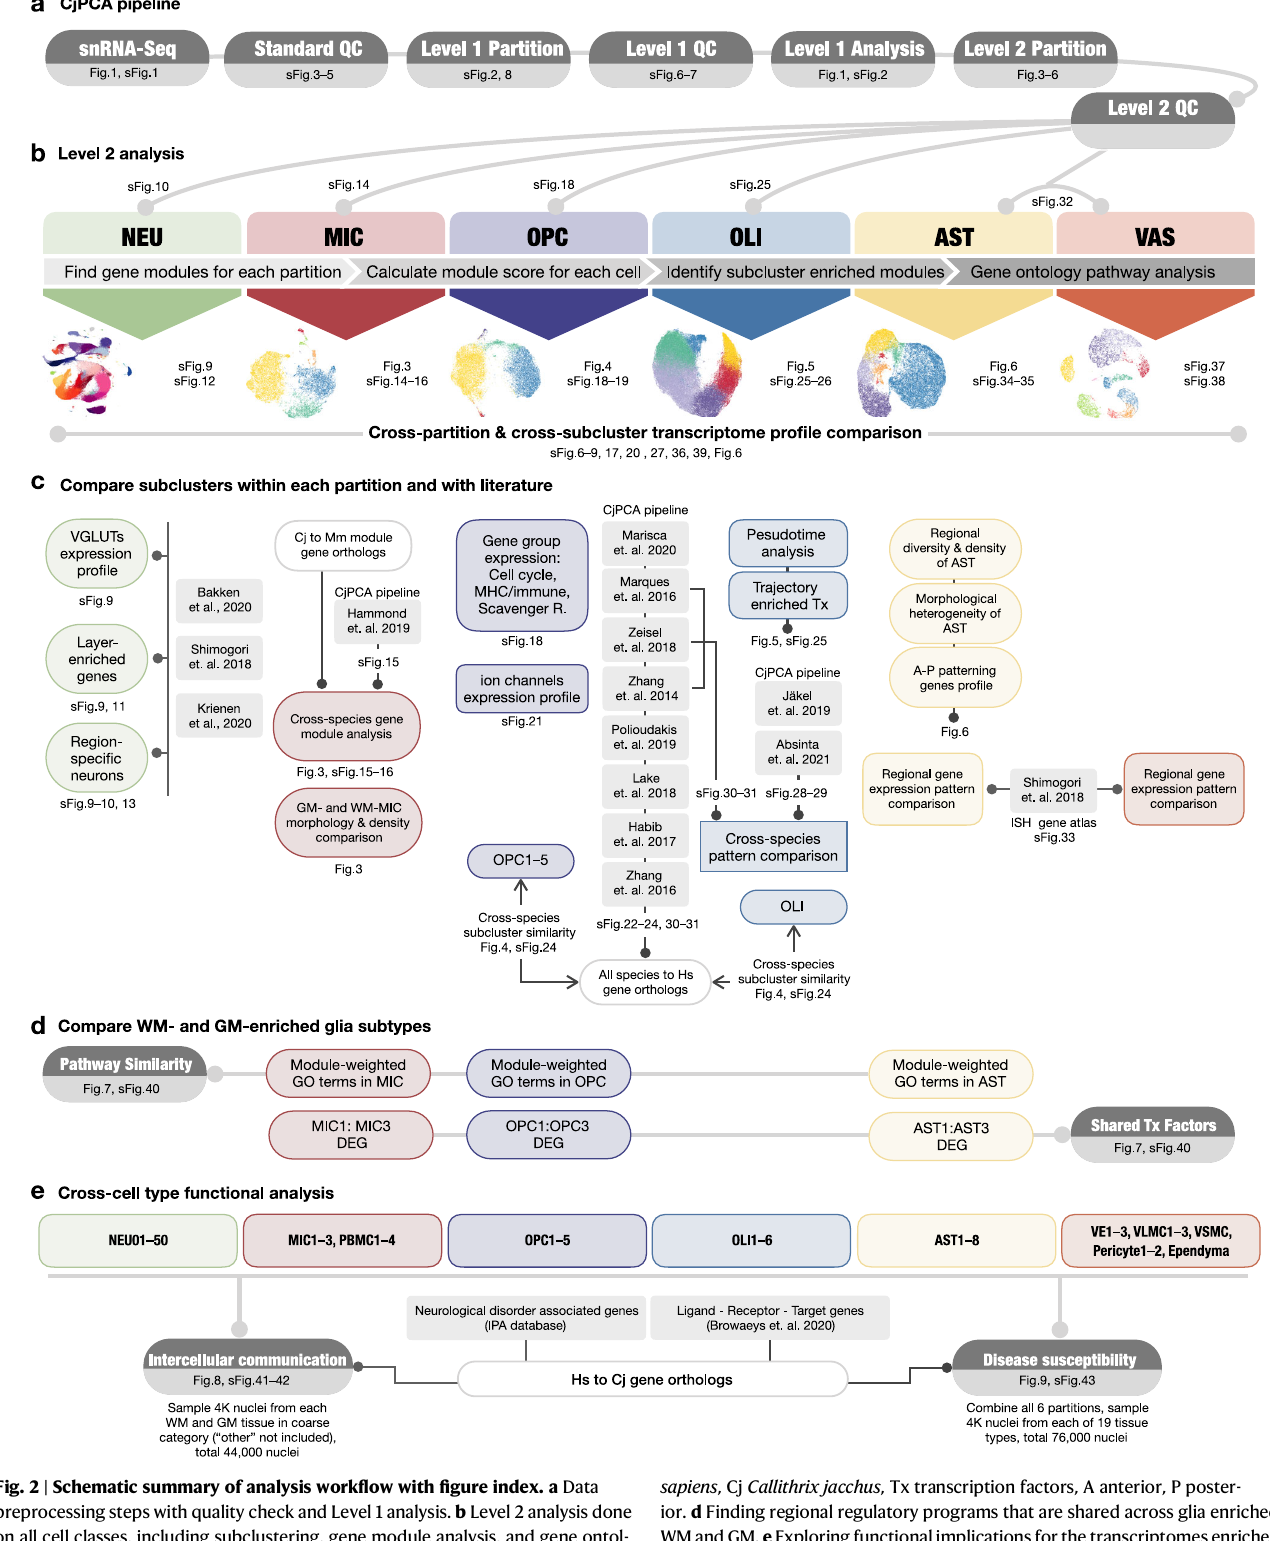
sapiens , Cj Callithrix jacchus , Tx transcription factors, A anterior, P poster- ior. d Finding regional regulatory programs that are shared across glia enriched in WMandGM. e Exploringfunctionalimplicationsforthetranscriptomesenrichedin WM- and GM-glia by assessing intercellular communication and disease suscept- ibility. Hs Homo sapiens, Cj Callithrix jacchus